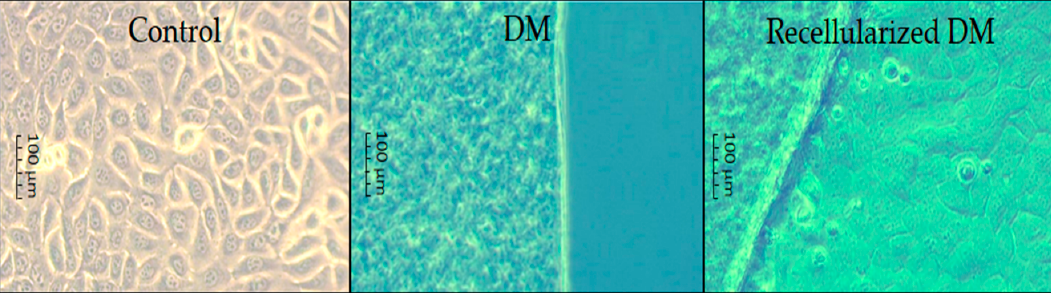
Figure 4. Images of cell culture on DM for mammalian skin cells obtained using an inverted microscope (40 × ).